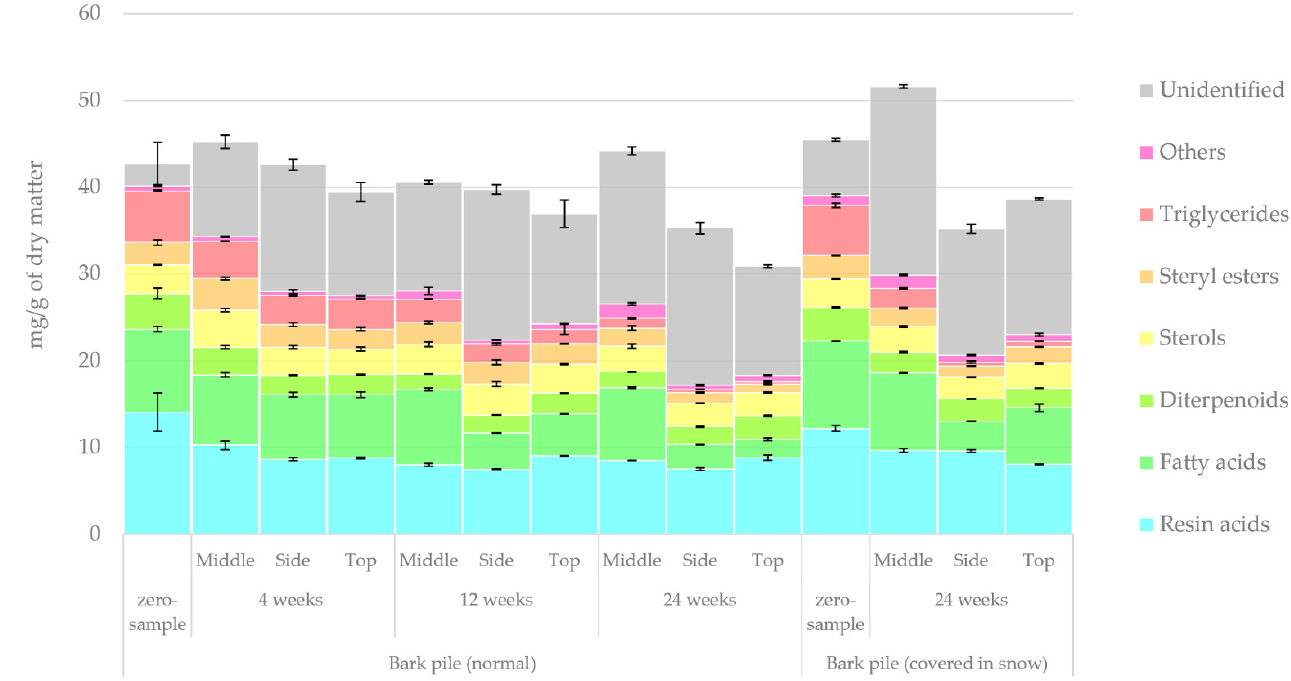
Figure 3. Lipophilic extractive groups in bark samples during pile storage.